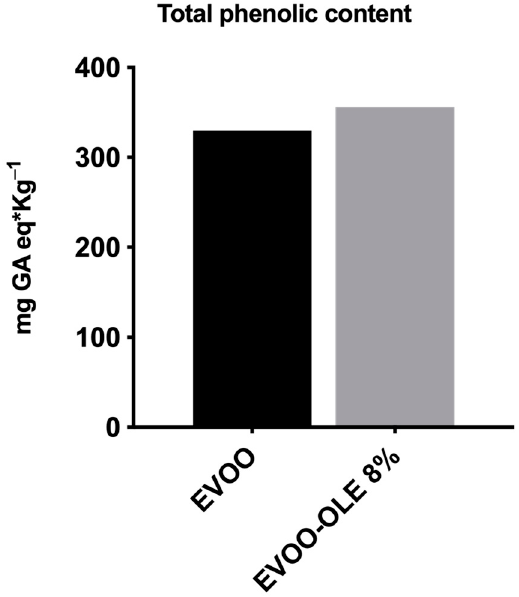
Figure 2. Total phenolic content (TPC) of EVOO and EVOO/OLE 8% extracts.